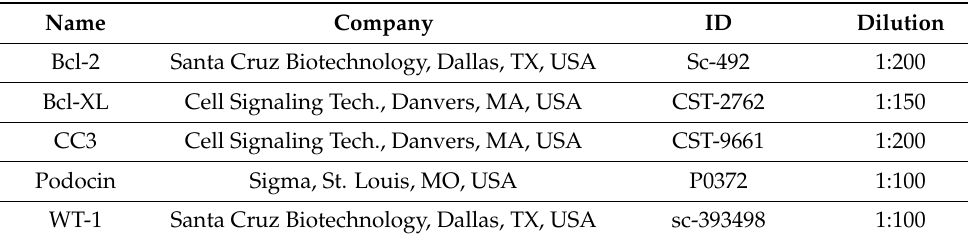
Table 2. Primary antibodies for IHC